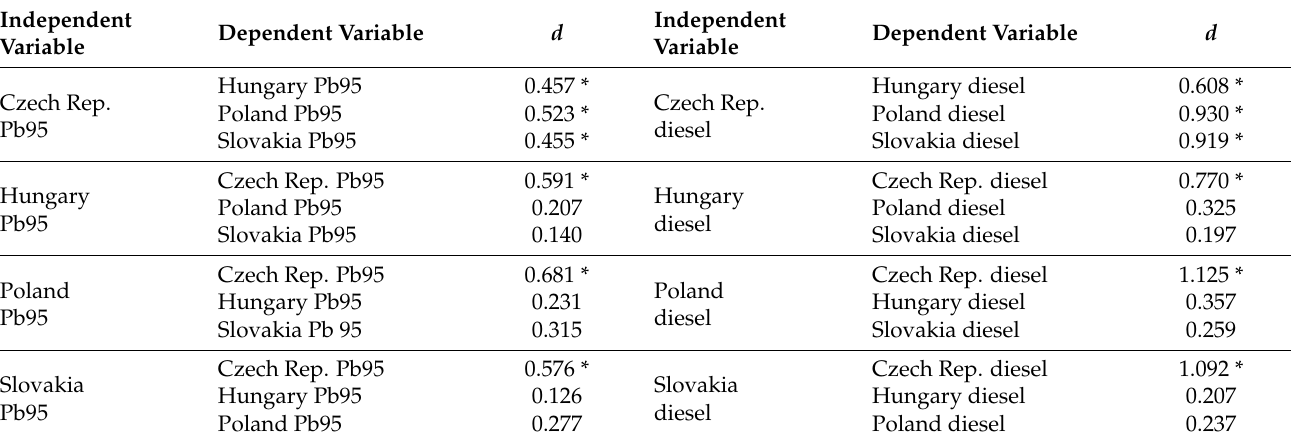
Table 6. The CRDW test results for Pb95 gasoline and diesel